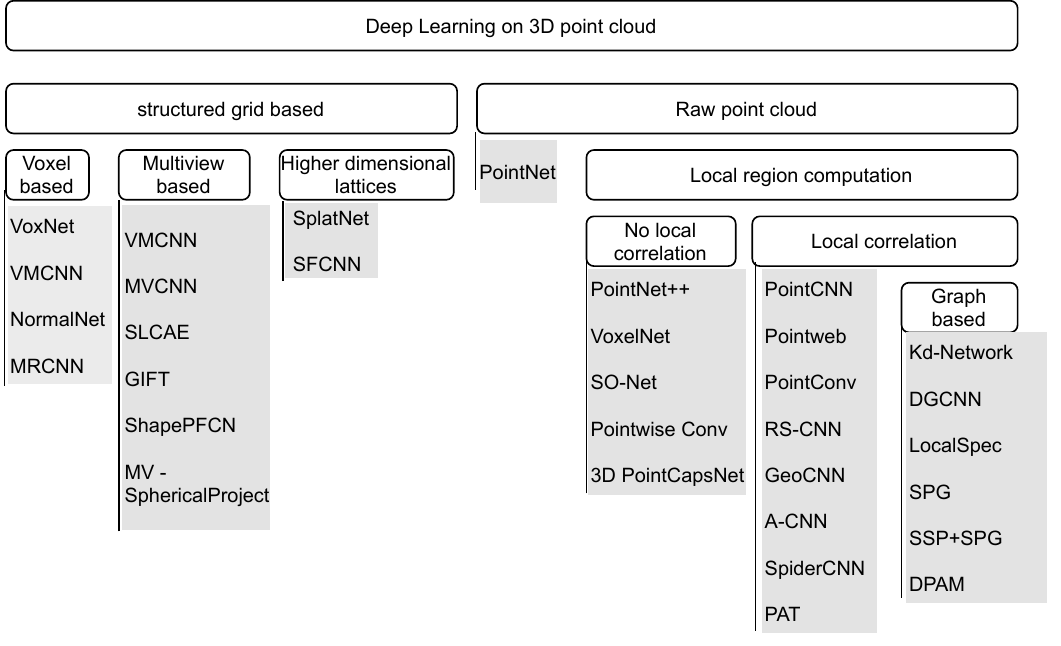
Figure 1. Overview of deep learning approaches on point